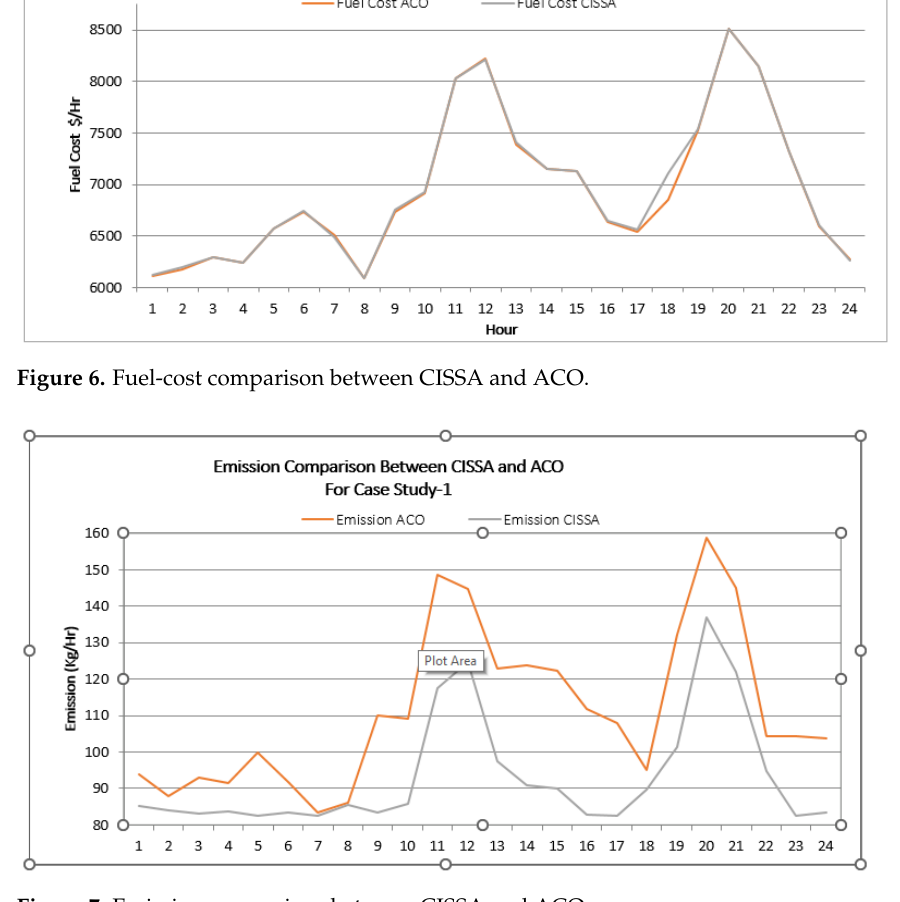
Figure 7. Emission comparison between CISSA and ACO. The overall result related to the emissions is presented in Table 7. Table 7. Emission comparison between CISSA and ACO .